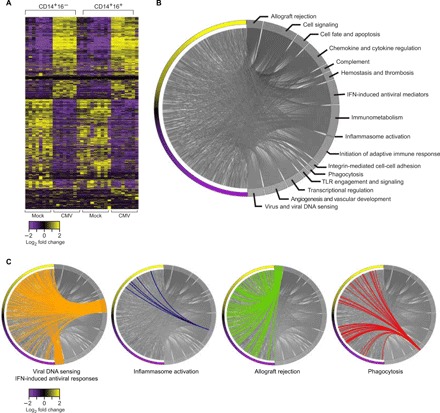
Unbiased sequencing defines a distinct monocyte-CMV transcriptional signature.(A) Heat map with hierarchical clustering showing genes differentially expressed in mock-infected CD14+/16−, CMV-infected CD14+/16+/GFP+, mock-infected CD14+/16−, and CMV-infected CD14+/16−/GFP+ monocytes. (B) Chord diagram illustrating GSEA of the 2167 differentially expressed transcripts in CMV-infected CD14+/16− monocytes defines 16 categories of biological processes dysregulated in CMV-infected monocytes. (C) Chord diagrams highlighting differentially expressed genes within the MSigDB-Hallmarks and InnateDB summary terms viral DNA sensing and IFN-induced viral mediators, inflammasome activation, allograft rejection, and phagocytosis.